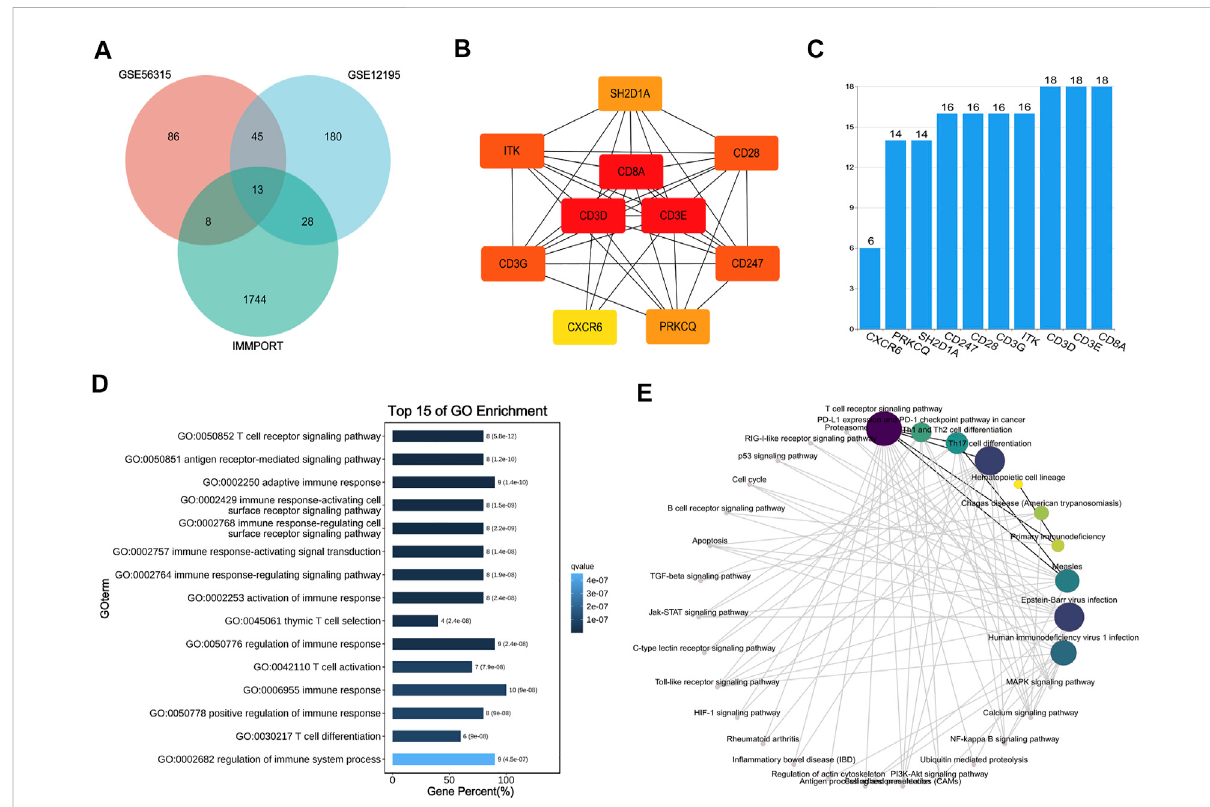
FIGURE 8 Interaction network and enrichment analysis of hub genes. (A) Venn diagram of GES56315, GSE12195 and IMMPORT database. (B) Protein- proteininteraction (PPI) network of10hubgenes. (C) The histogram for numberofgene-geneinteractions. (D,E) GO andKEGGenrichmentanalysis of 10 hub